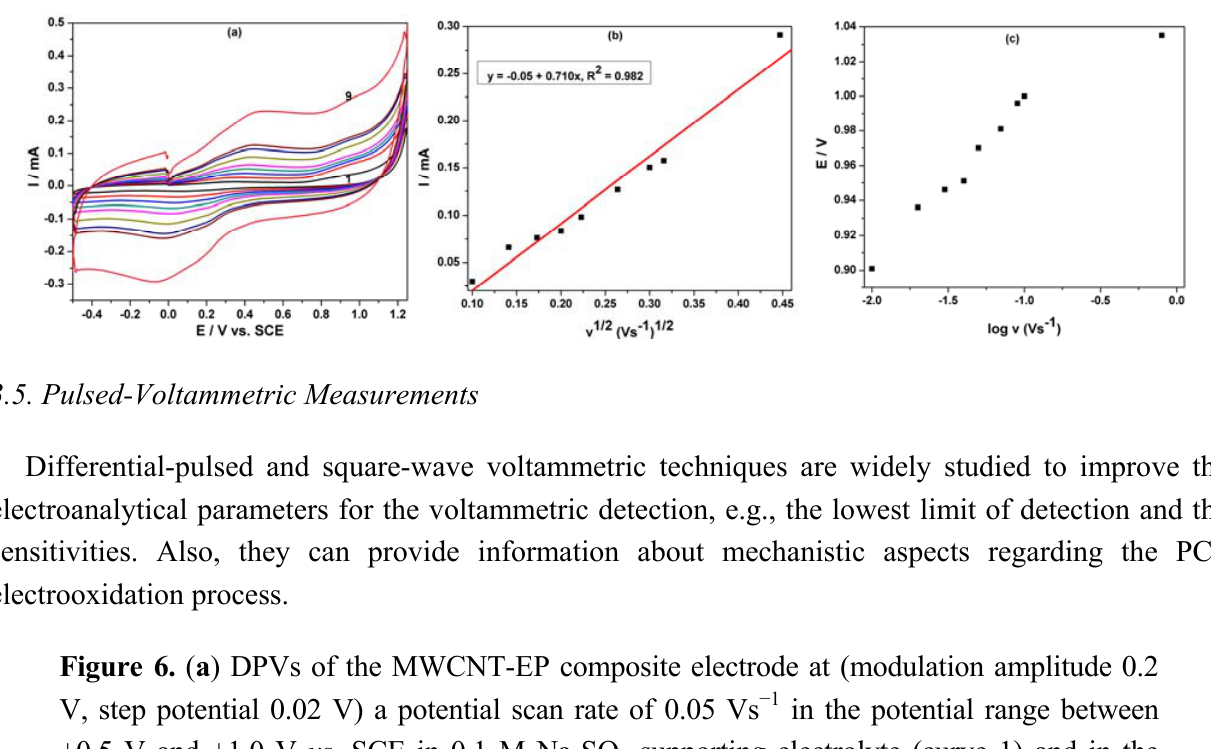
Figure 5. ( a ) Cyclic voltammograms of 8 µM PCP at the MWCNT-EP composite electrode in 0.1 M Na SO supporting electrolyte (1) with different scan rates: 0.01, 0.02, 2 4 0.03, 0.04, 0.05, 0.07, 0.09, 0.1, 0.2 Vs − 1 ; potential range: –0.5 and +1.25 V/ SCE. ( b ) The anodic peak current vs . square root of scan rate. ( c ) The peak potential Ep vs . log (v).